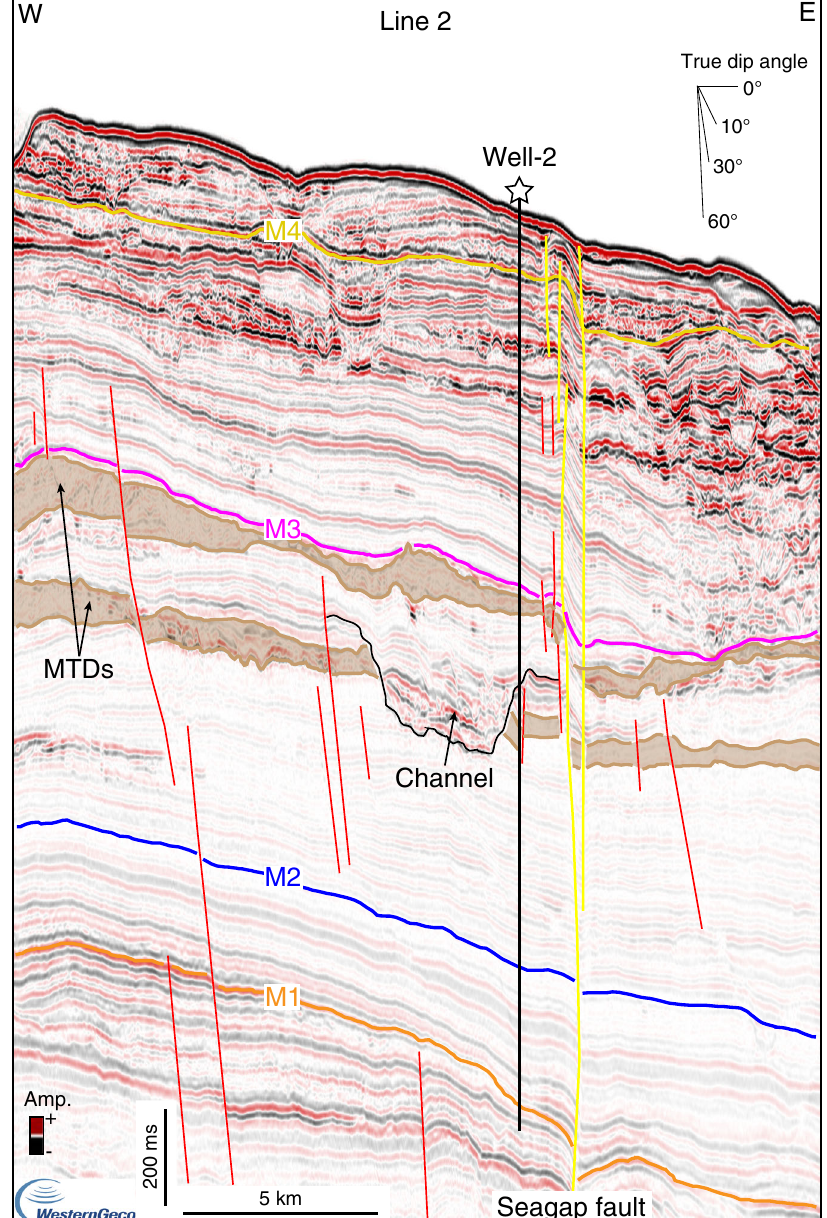
Fig. 4 Stratigraphy of the Tanzania margin imaged by a downslope-oriented seismic line crossing Well-2. Seismic Line 2, oriented W-E, crosses Well-2 offshore the northern Rovuma River delta. In this area, the oldest major mass-transport deposits (MTDs) accumulated during the Burdigalian (see Fig. 2 for the ages of the horizons). Noninterpreted version of Line 2 is available in the Supplementary Fig.